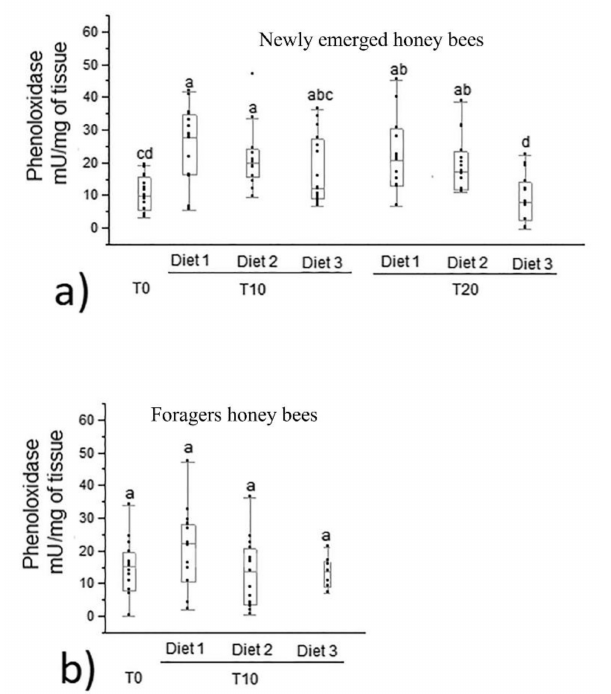
Figure 4. Phenoloxidase activity in newly emerged ( a ) and forager ( b ) honey bees fed control and experimental diets (diet 1, diet 2, diet 3 with 0.3%, 1.7% and 7.7% of protein content, respectively). Different letters indicate statistical significance ( p < 0.0001) by Kruskal–Wallis test. Data were expressed as mU/mg of tissue (median, min and max values). T0, T10, T20 were the days of honey bees sampling, n = 15 per bar.